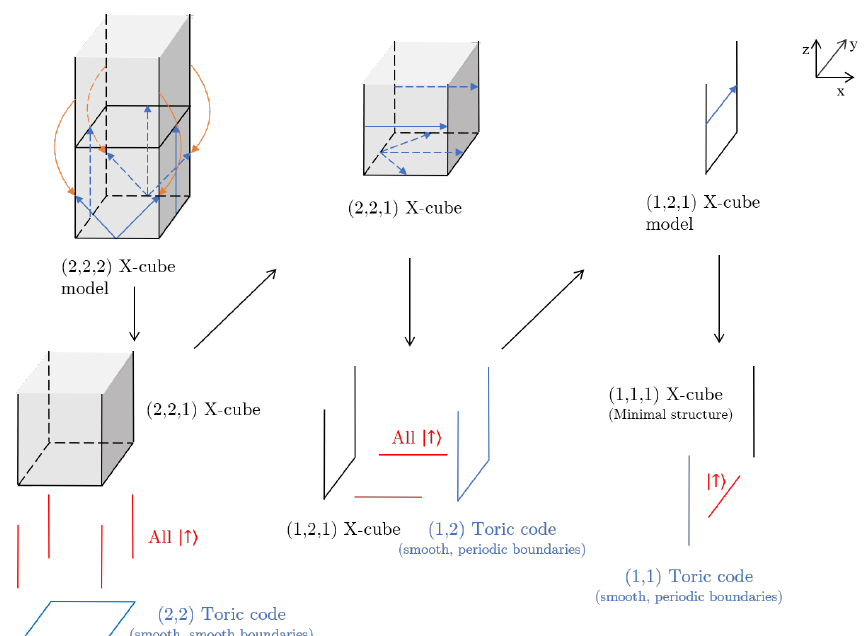
Figure 13: Using local unitaries to reach the minimal structure of the X-cube model with smooth boundaries along x , y and periodic boundaries along z . The last local unitary (just the single CNOT gate) commutes with the 2 × 1 × 1 X-cube Hamiltonian and doesn’t change the ground space, but we are including it to show the straight- forward pattern with which one can exfoliate (even small) leaves.